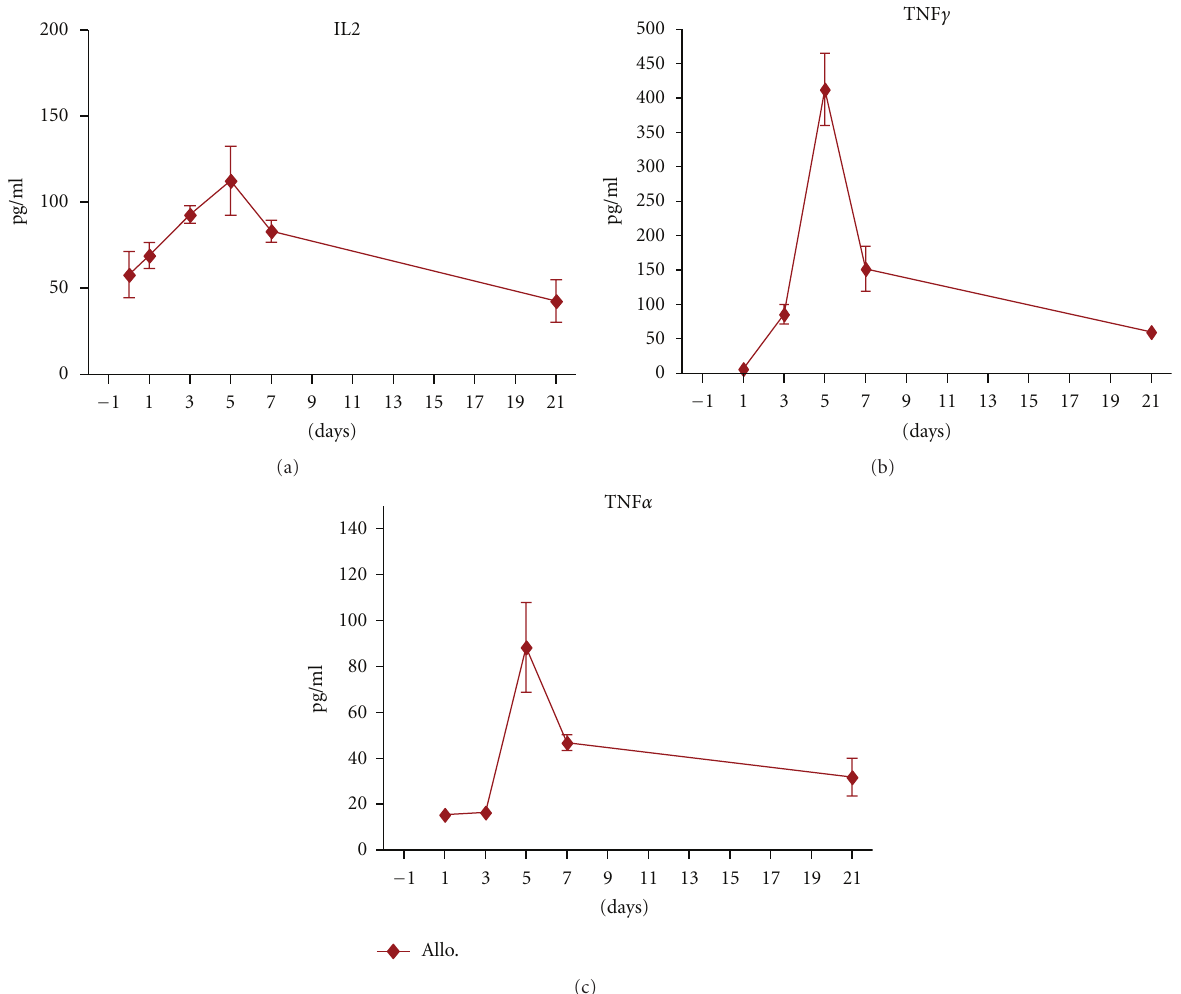
Figure 5: Cytokine levels in the serum of GVHD developing mice. Inflammatory cytokine levels were measured in the serum of allogeneic transplanted BALB/c mice at di ff erent time points before and after BMT. (a) IL-2, (b) IFN gamma, and (c) TNF-alfa levels in the serum of GVHD mice. All of the inflammatory cytokines showed maximum level 5 days after BMT in GVHD mice. Serum level of these cytokine was not detectable in syngeneic setting. ( (cid:2) ): allogeneic setting Di ff erences were analyzed statistically employing U -test, compared between groups ( ∗ P < .